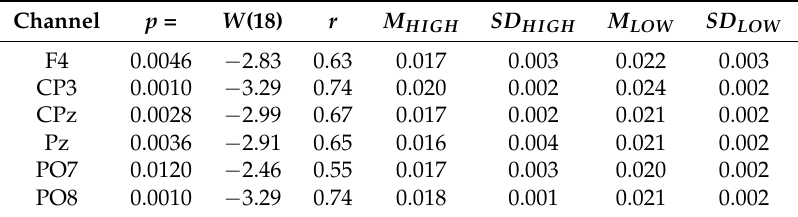
Table A7. Eyes-Open (EO) setting. Channel-wise paired Wilcoxon rank sum test for six channels (F4, CP3, CPZ, PZ, PO7, and PO8) in which significantly higher total TEs were associated with LOW stress-susceptible group. p , W , and r refer to p -value, test-statistics, and the effect size for Wilcoxon rank sum tests. M and SD are the mean and standard deviation of these channels’ total TE values. The subscripts to M and SD mark the two groups. All these significant differences were characterized by strong effect sizes, as indicated by the “ r ” column entry of this